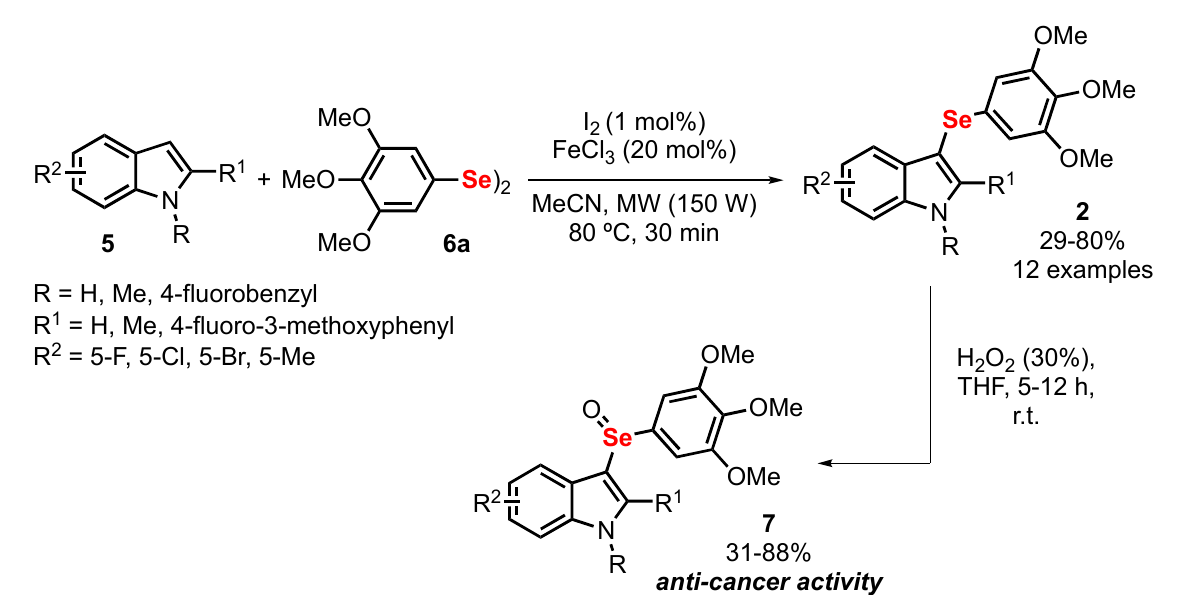
Scheme 1. MW ‐ promoted synthesis of 3 ‐ selenylindoles ( 2 ).